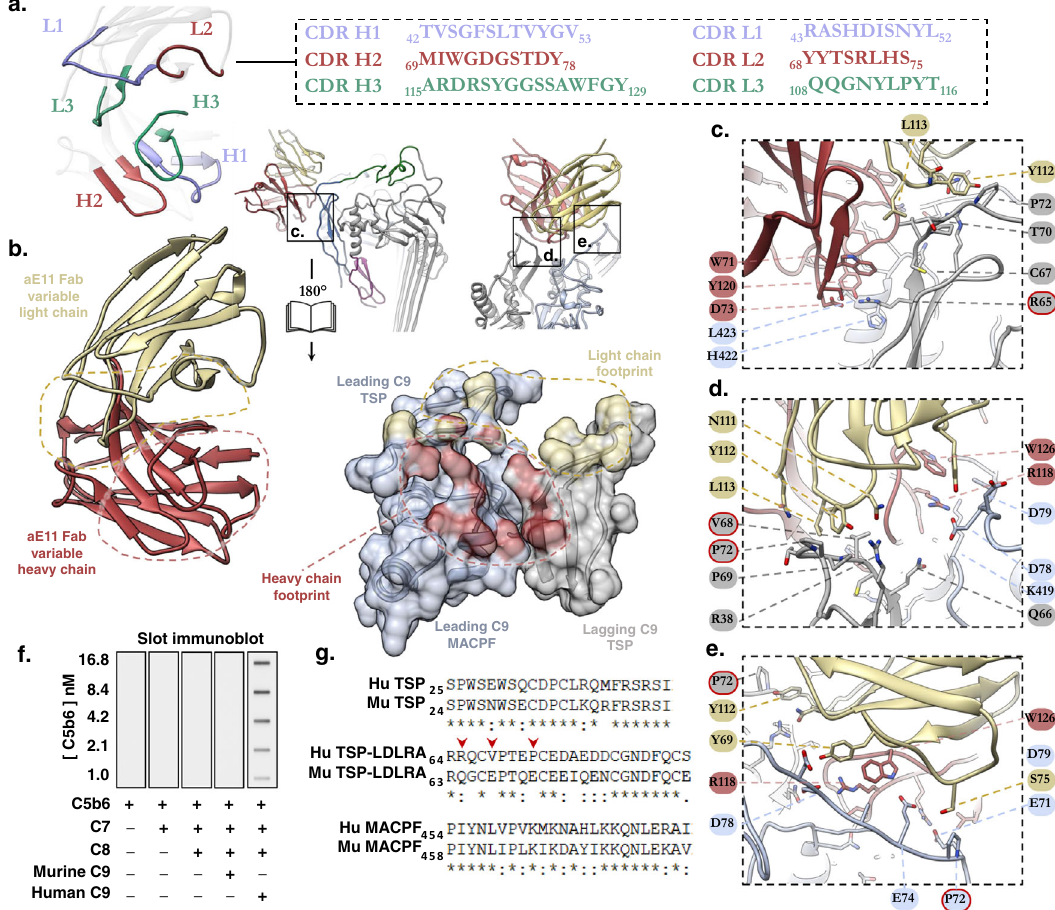
Fig. 2 Structural basis of aE11-Fab/polyC9 binding. a Illustration of the aE11-CDRs (coloured, blue, green, red) on the antibody and its corresponding primary sequence. b Focused view of the opened aE11-polyC9 interface (split by 180°) that de fi nes the MAC neoepitope. Left: close-up structure of the aE11-CDRs. Right: Transparent surface and cartoon illustration of the leading (light blue) and lagging (grey) C9 subunits, where the footprints of heavy and light chain binding regions are shaded red and yellow, respectively. A dashed line illustrates the buried surfaces of the interface. c – e Key regions of antibody binding to C9. Locations of these regions correspond to the boxed regions in ( b ). Mutated residues for validation studies are encircled in a red outline. f Slot immunoblot of aE11 binding to the oligomeric C9 component of whole MAC. Oligomeric human C9 is recognised by aE11, but not oligomeric mouse C9. MAC assembly intermediates (C5b6, C5b-7, C5b-8) are included as controls. Concentrations of C5b6 are marked for each condition. The C7, C8 αβγ , and C9 concentrations were constant at 30, 30, and 7 nM, respectively. g Sequence alignment of the linear regions of human and murine C9 that contribute to the quaternary discontinuous